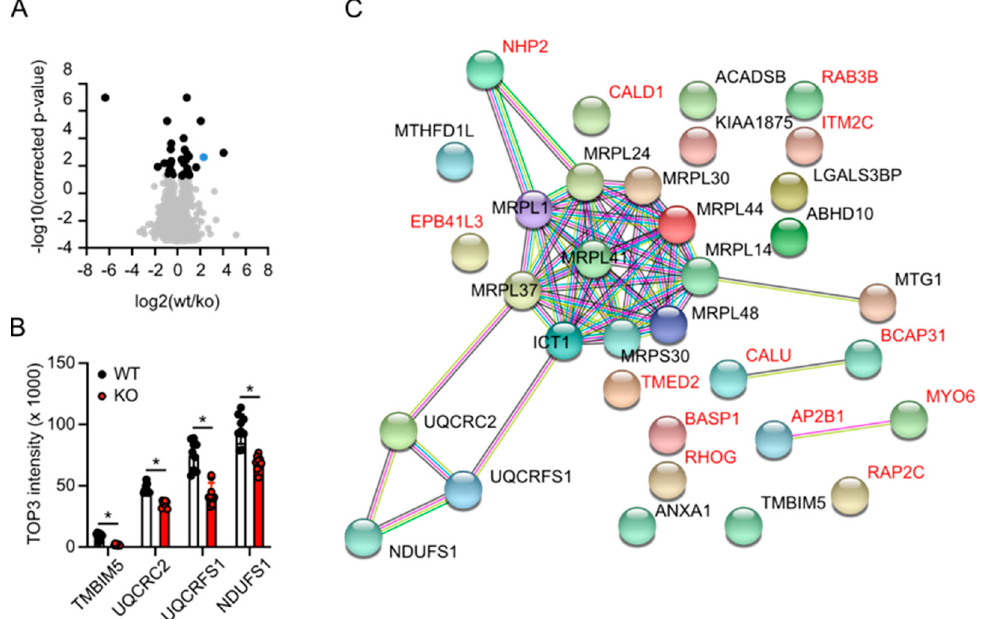
Figure 5. Proteome analysis identifies dysfunctional mitochondrial translation in TMBIM5-KO cells. The protein abundance in WT and TMBIM5-KO mitochondrial fractions was compared by label-free quantitative mass spectrometry. ( A ) Volcano plot of 35 dysregulated proteins. Blue dot represents TMBIM5. ( B ) Downregulated proteins of the respiratory transfer system, each data point corresponds to one of three biological with three technical replicates. Bar graphs show the mean ± SD. * p < 0.05 Welch’s t test. ( C ) STRING analysis of the dysregulated proteins in TMBIM5-KO compared to WT mitochondria; downregulated proteins are shown in black; upregulated proteins are shown in red.